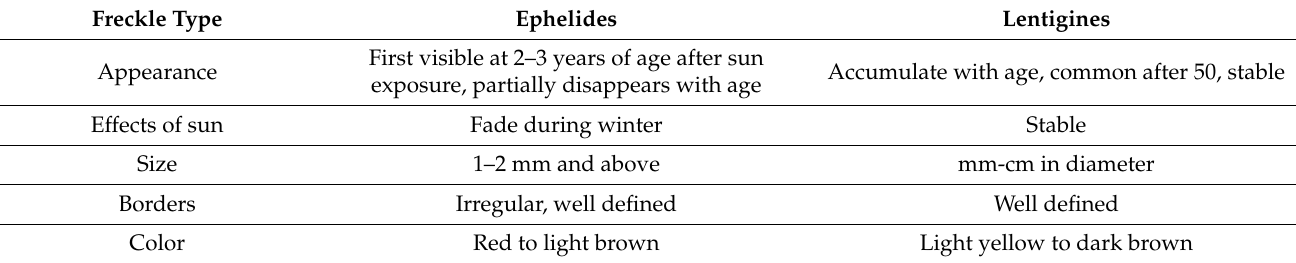
Table 3. Types of Face Wrinkle in training sets